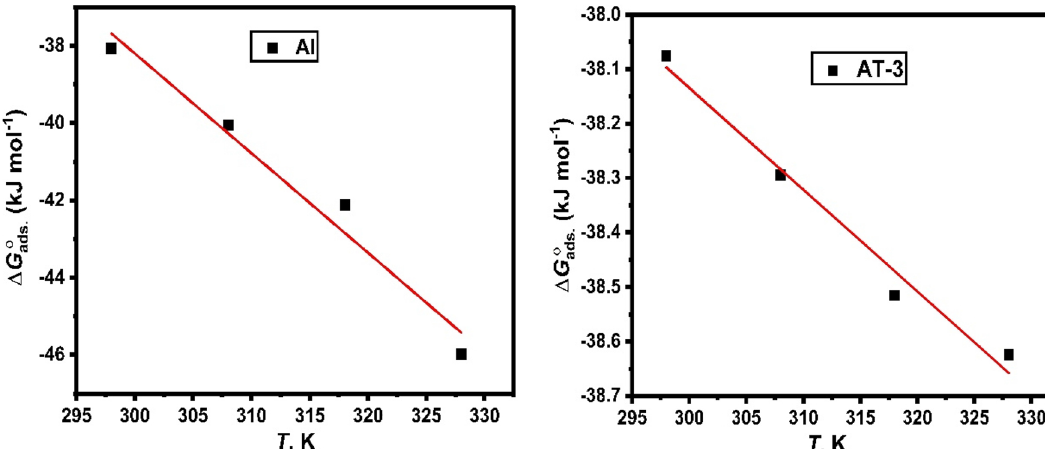
0 ads . against T of pure Al and AT-3 alloy in 0.5 M HCl solution comprising 2-MBT